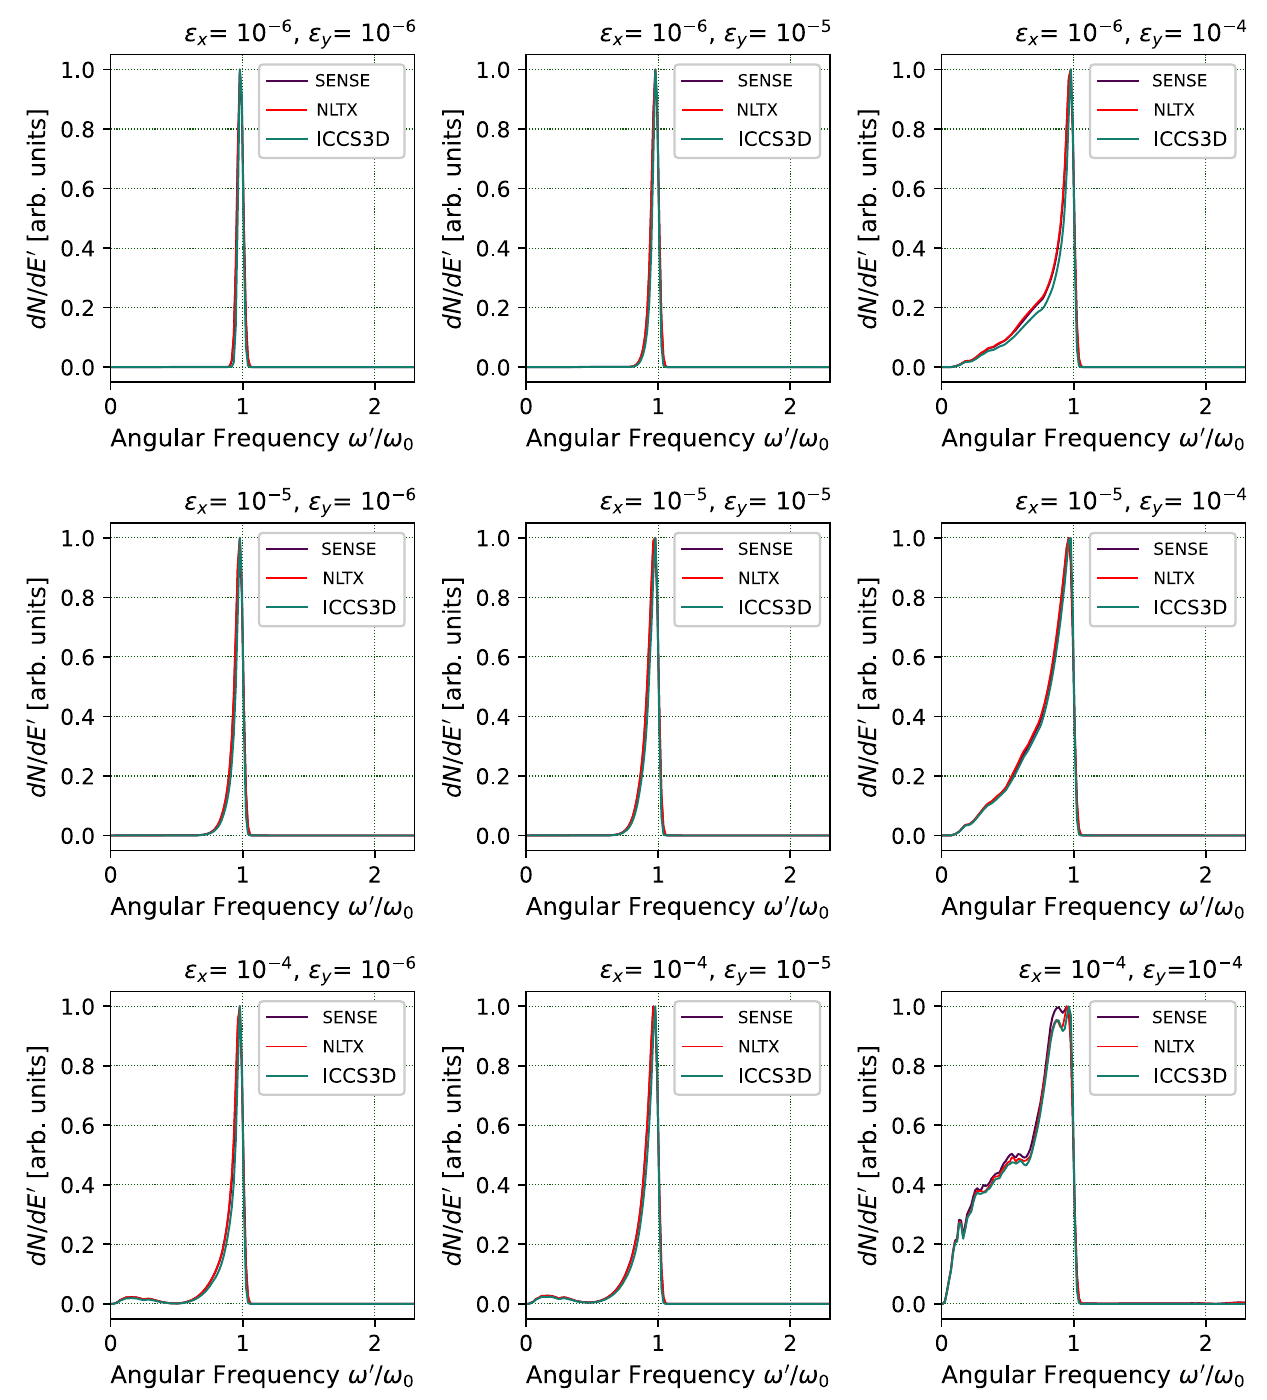
FIG. 3. Peak normalized simulated spectra from SENSE , ICCS3D, and NLTX for field strength a 0 ¼ 0 . 1 and a range of normalized horizontal emittance ϵ x and normalized vertical emittance ϵ y values. The following parameters were used in the simulations: ¼ 23 MeV; Δ E =E ¼ 0 . 175% ; σ ¼ 41 μ m; σ ¼ 81 μ m; λ ¼ 800 nm; σ E e e e x y scattered frequency is scaled by the normalizing frequency ω 0 ¼ 2 π c= λ